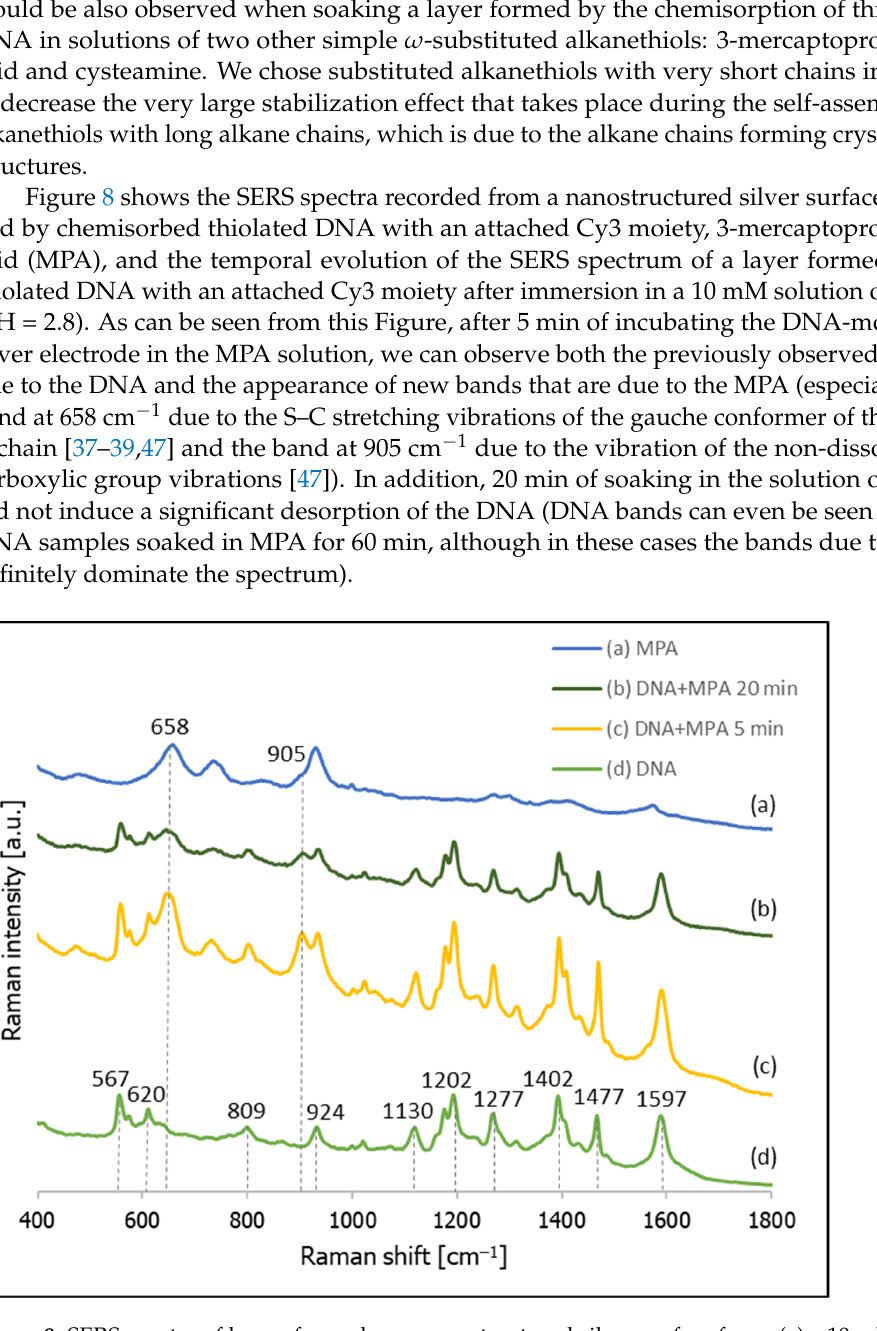
Figure 8. SERS spectra of layers formed on a nanostructured silver surface from: ( a ) a 10 mM MPA solution, ( b ) thiolated DNA labelled with Cy3 and immersed for 20 min in a 10 mM MPA solution, ( c ) thiolated DNA labelled with Cy3 and immersed for 5 min in a 10 mM solution of MPA, and ( d ) thiolated DNA labelled with Cy3.